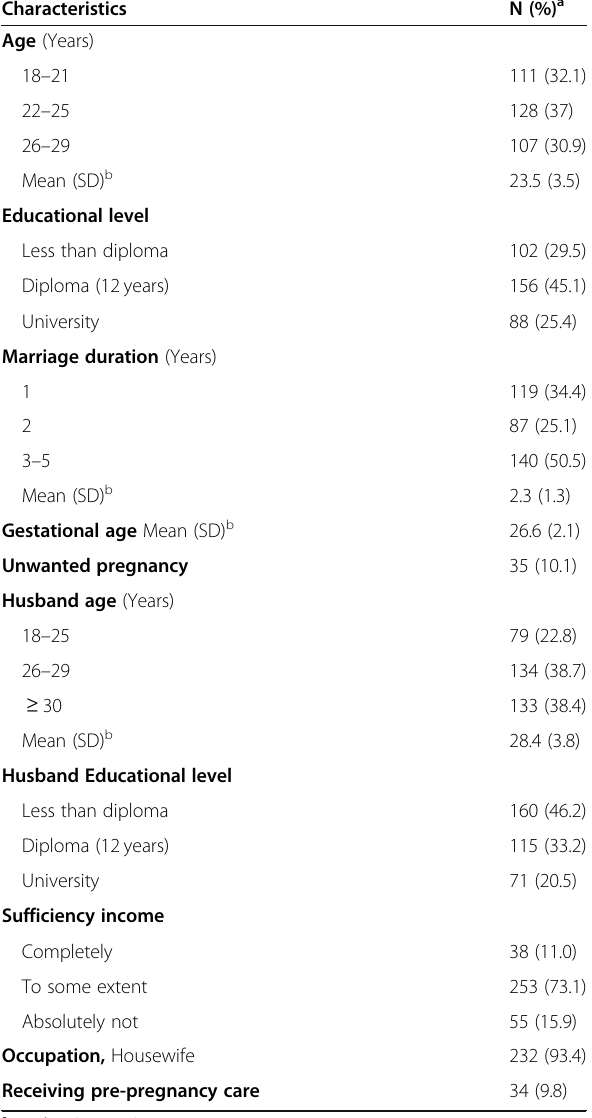
Table 1 Socio-demographic characteristic in young